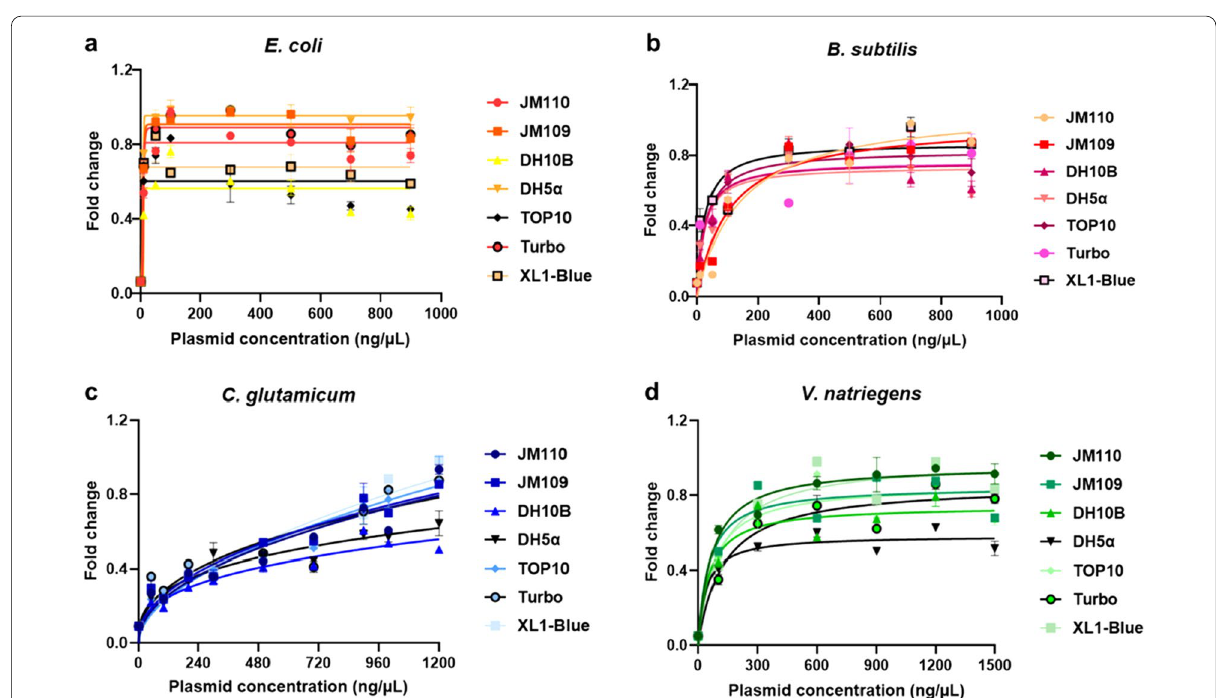
Fig. 3 Screening of competent cells and DNA concentrations in E. coli , B. subtilis , C. glutamate and V. natriegens CFPS systems. a E. coli CFPS system. b B. subtilis CFPS system. c C. glutamicum CFPS system. d V. natriegens CFPS system. The data were normalized. The mean and standard